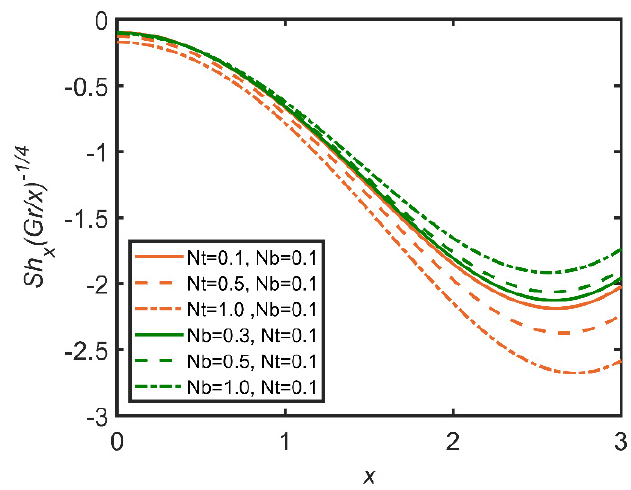
Figure 5. Comparison for Sherwood number against x.